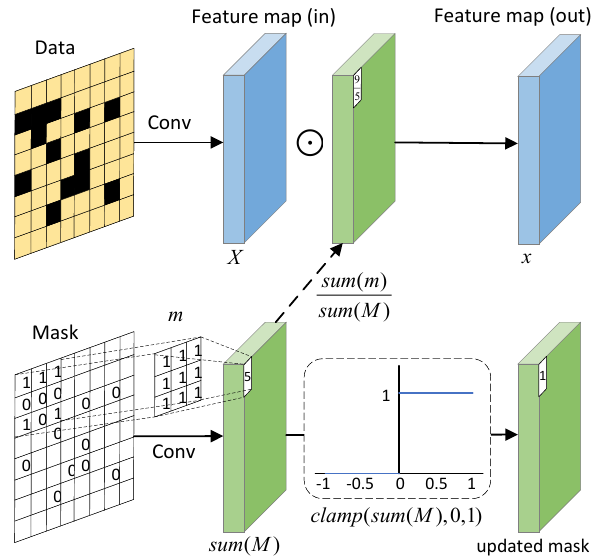
Figure 3. Partial convolution. Input the masked meteorological data and corresponding mask into PCnov to obtain the feature map and the updated mask. Partial convolution operation is divided into convolution operation on the masked data and updating the mask. The feature map (in) obtained by convolution operation is affected by the mask to obtain the final feature map (out), where (cid:12) is the element-wise multiplication and function clamp ( M , min , max ) compresses the values in the matrix M into the interval [ min , max ] .